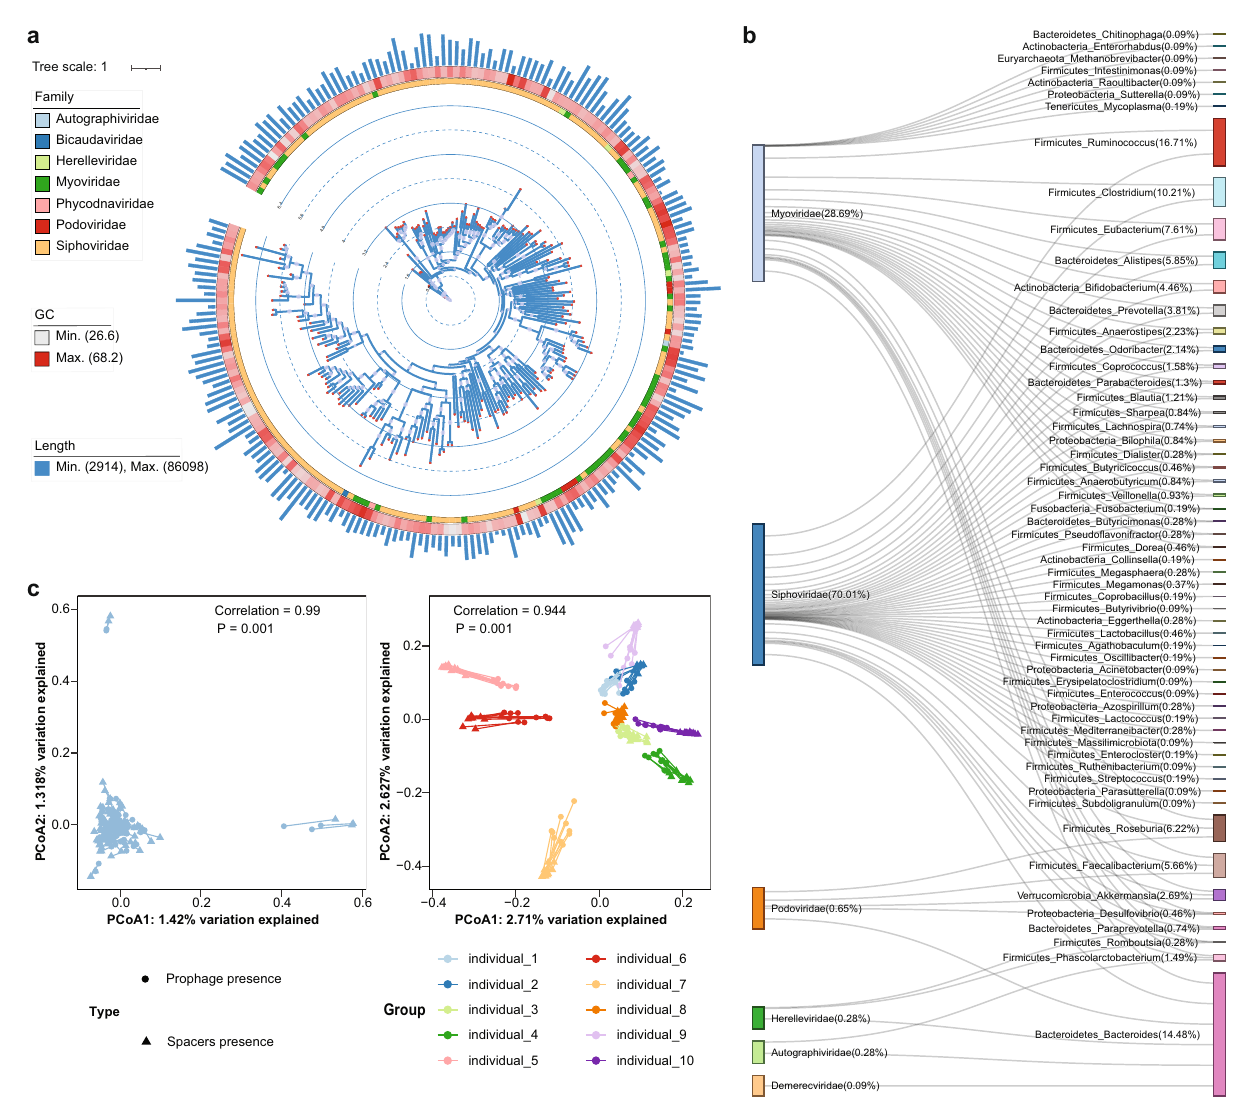
Fig. 4 ONT-improved metagenome contained highly diverse prophages and CRISPR spacers in human gut microbiome. a Phylogenetic distribution of 228 prophages with both complete major capsid protein (MCP) and terminase large subunit (TLS) proteins (see Methods and Results section) discovered from 200 samples, with length distribution from 2.9 to 86 kb (scaled in barplot). For each sequence, the assigned viral family was indicated in color and the length of each prophage was shown as bar length in the outer circle. b Prophage-host pairs determined by analyzing prophage sequences and fl anking regions. Prophages were grouped at the family level and bacteria at the genus level, with each side showing the percentage of family/genus among all the sequences. c Procrustes analysis of prophage/CRISPR spacer structures in the cross-sectional cohort (left) and time-series cohort (right), showing signi fi cant correlations between their overall compositions and indicating the highly stable prophage/CRISPR spacers structures within the same individual across time points. The statistical signi fi cance of the procrustes results were assessed using function protest with 999 permutations. The p value for both statistical tests was on bacterial abundance. Further incorporating ONT reads in gut microbiome research will enable in-depth dissection of time- speci fi c gut microbiome functionality and deepen our under- standing of various gut-disease axes in humans.